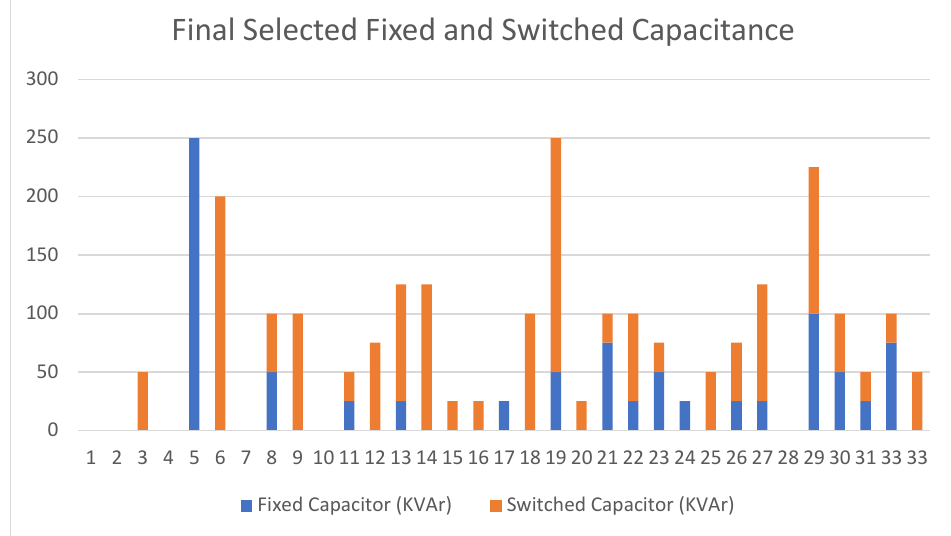
Figure 10. Final response capacitance status in the studied network.